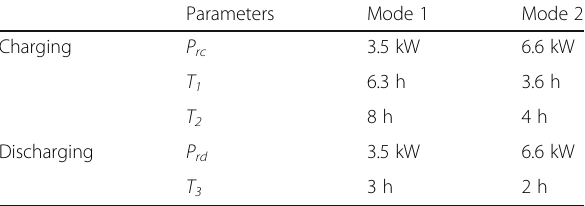
Table 1 Parameters of EVs battery charging/discharging